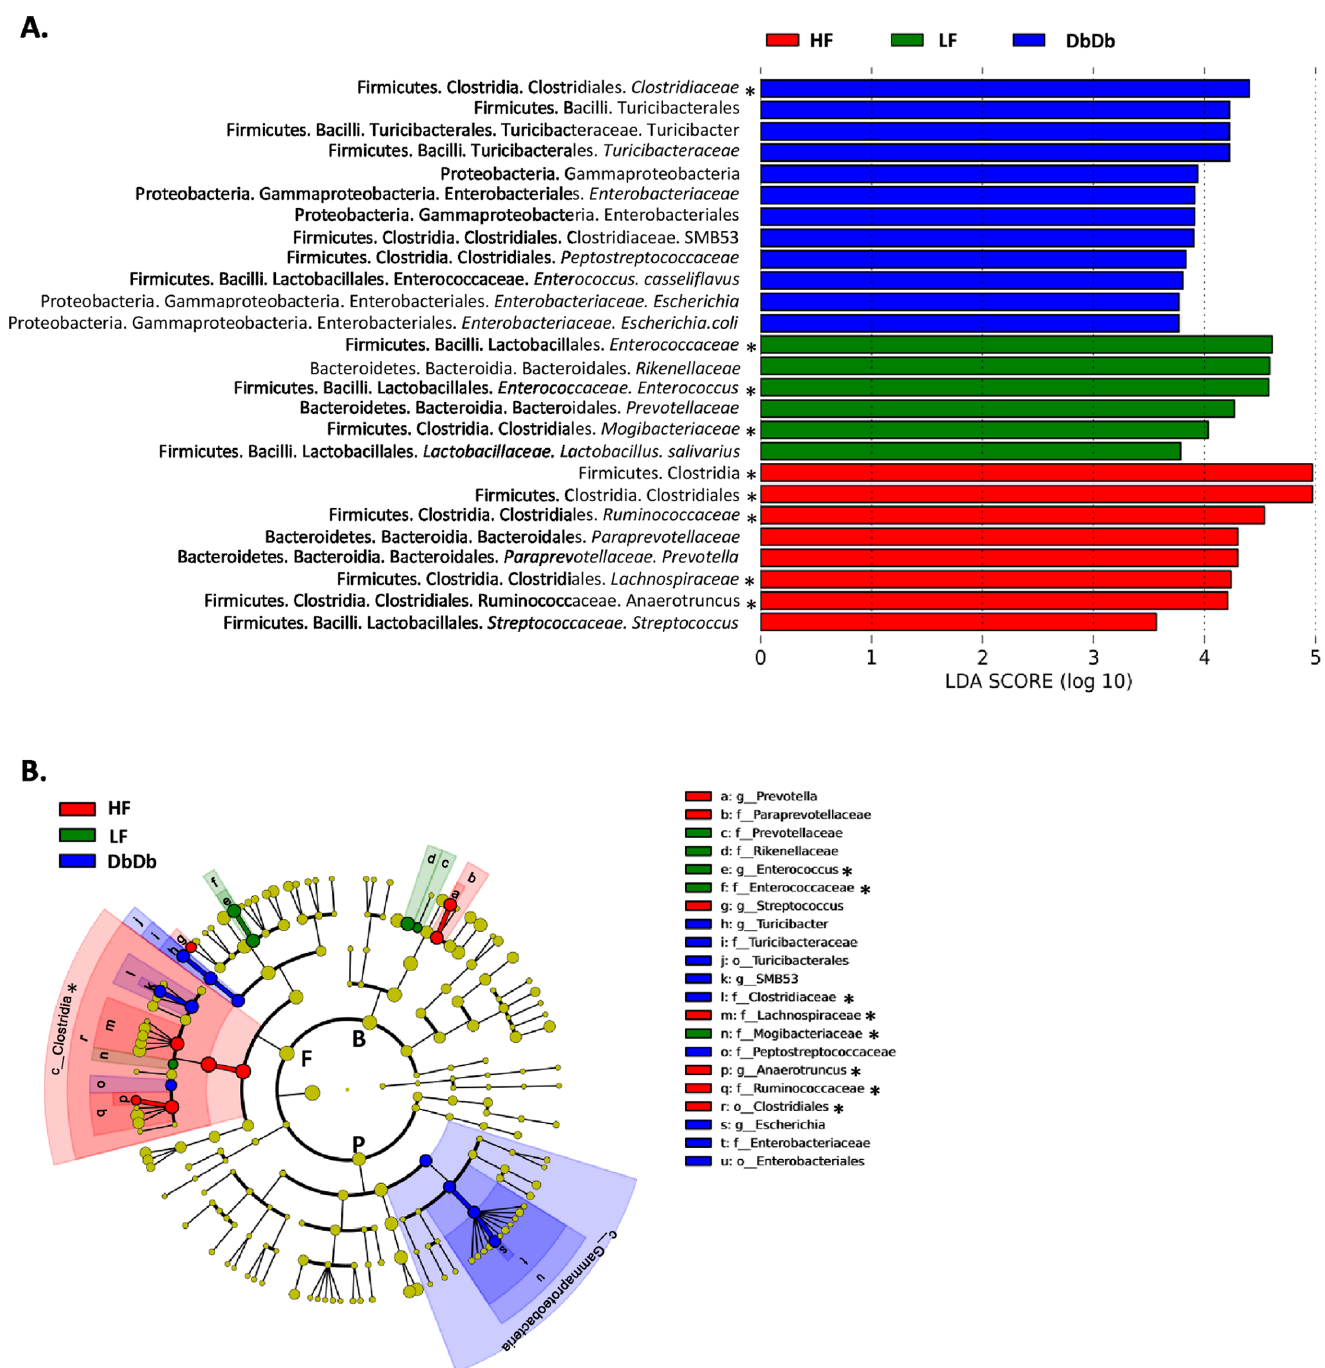
Fig 2. LDA effect size analysis of between group differences in stool bacterial abundances in Apc 1638N mice. A) Output showing effect size of 29 significantly enriched taxa in each group. Model = group x gender. B) Significant taxa plotted onto a cladogram. F, Firmicutes; P, Proteobacteria; B, Bacteroidetes; c_, class; o_, order; f_, family; g_genus, s_, species. * taxa that were also associated with that group in the MaASLin analysis. N = 29.